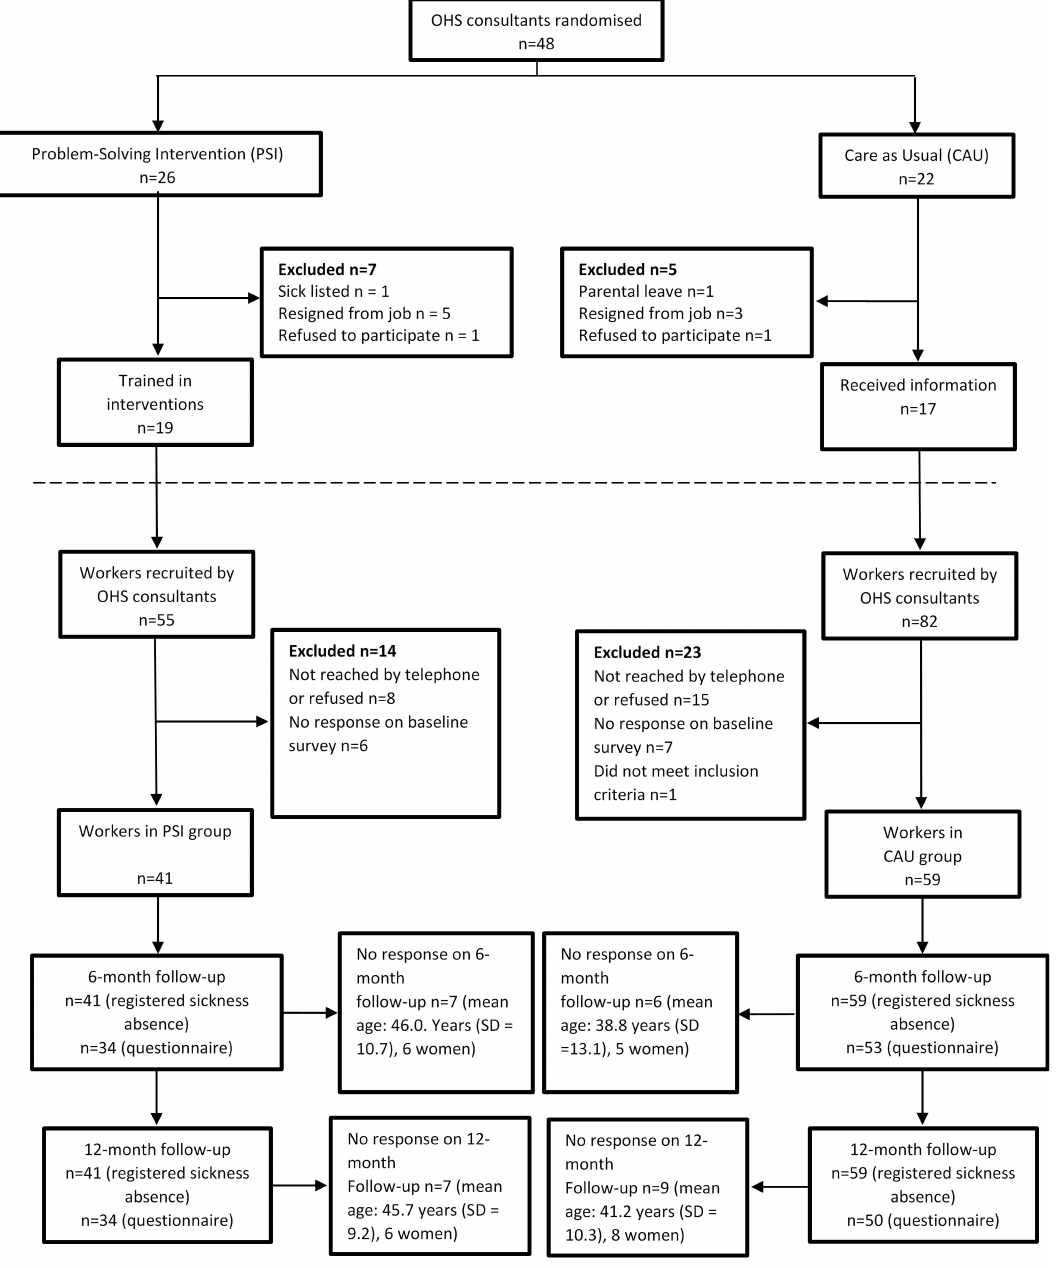
Figure 1. Flow diagram showing the recruitment of consultansts, experimental and control